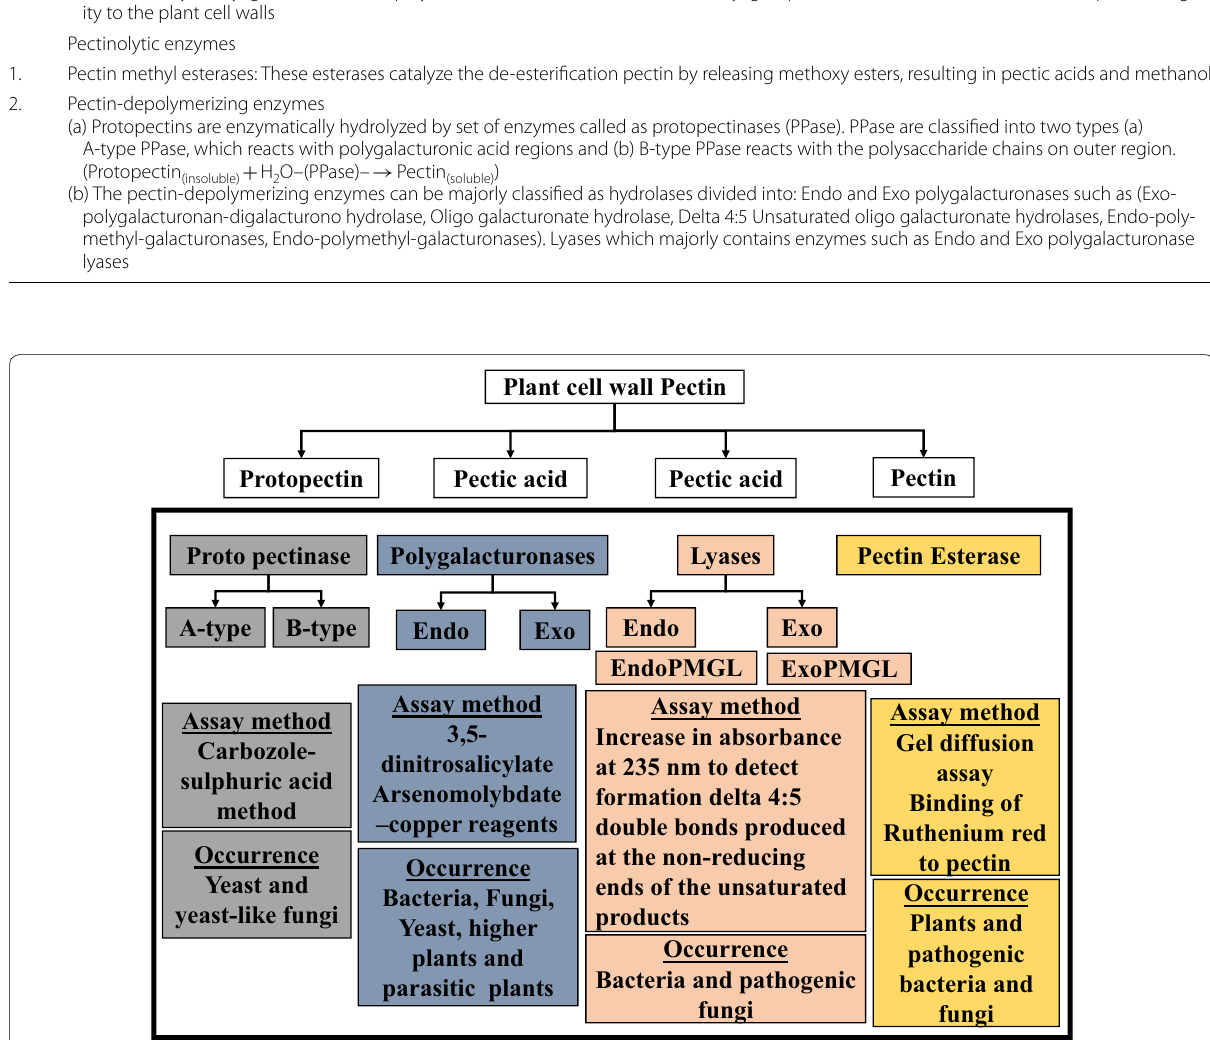
Fig. 1 Brief illustration of different pectin-degrading enzymes, its occurrence and assay methods used for its